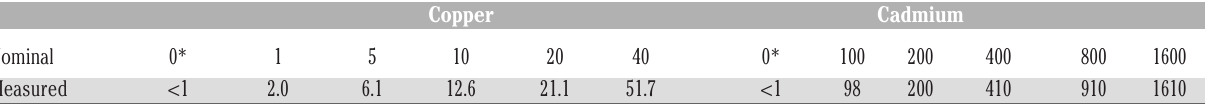
Table 1. Copper and cadmium concentrations (µg.L –1 ) determined for exposure solutions. Copper